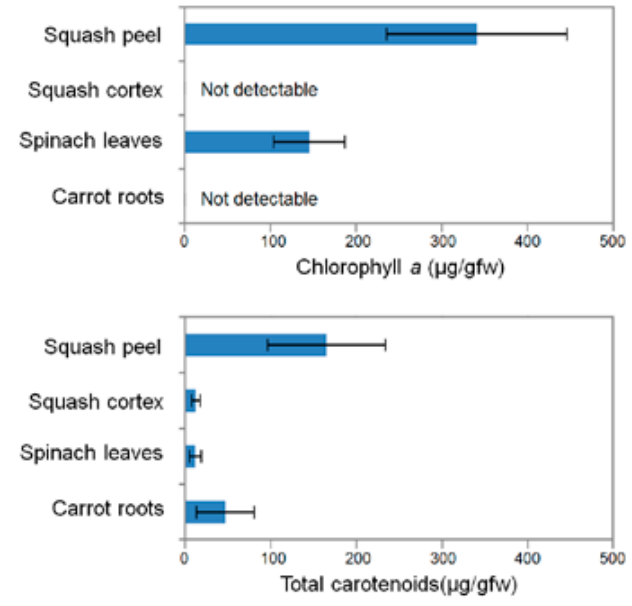
Fig. 5 - Quantification of pigments extracted from vegetable samples. Chlorophyll contents (top) and total carotenoid contents (bottom) in the extracts from green squash peel, yellow squash cortex, spinach leaves, and carrot roots are compared. Bars, S. D. (n =